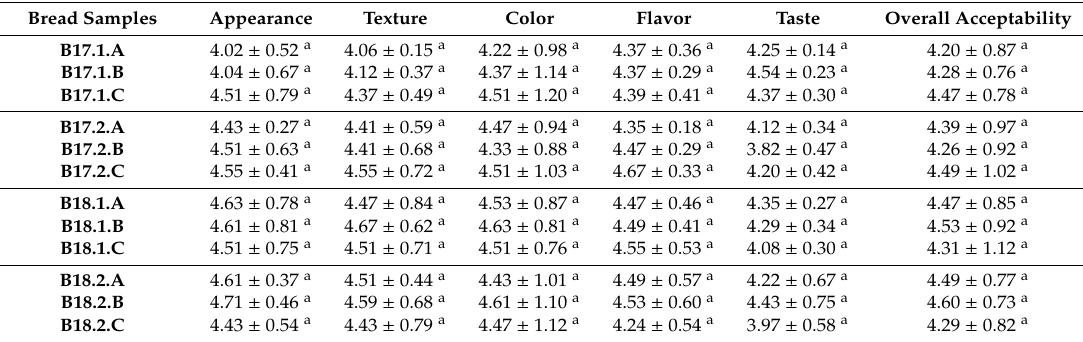
Table 5. Scores of sensory evaluation of bread samples. Bread Samples